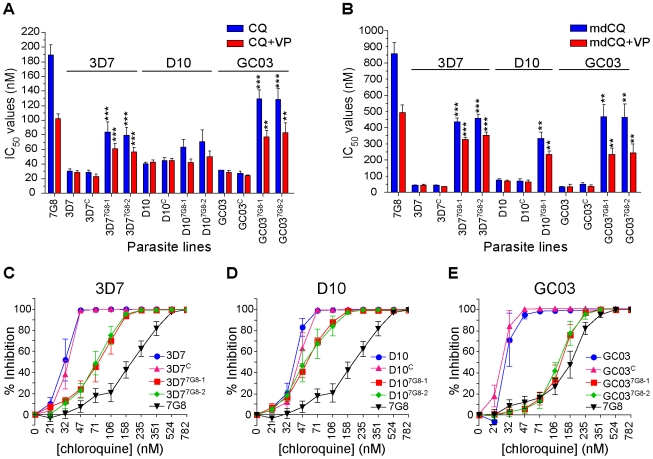

In vitro response of pfcrt-modified clones to chloroquine and its primary metabolite monodesethylchloroquine.
In vitro [3H]-hypoxanthine incorporation assays were performed with the WT, control, and mutant pfcrt clones. All lines were tested in duplicate against CQ±VP and mdCQ±VP an average of 7 times (range 4–11; see summary in Table S1). Mean±SEM IC50 values are presented for (A) CQ and (B) its metabolite mdCQ. Statistical comparisons comparing mutant pfcrt-modified lines against recombinant control lines of the same genetic backgrounds were performed using one-way ANOVA with a Bonferroni post-hoc test. **P<0.01; ***P<0.001. (C–E) Percent inhibition of growth (shown as means±SEMs derived from all assays) across a range of CQ concentrations for (C) 3D7, (D) D10, and (E) GC03 lines.